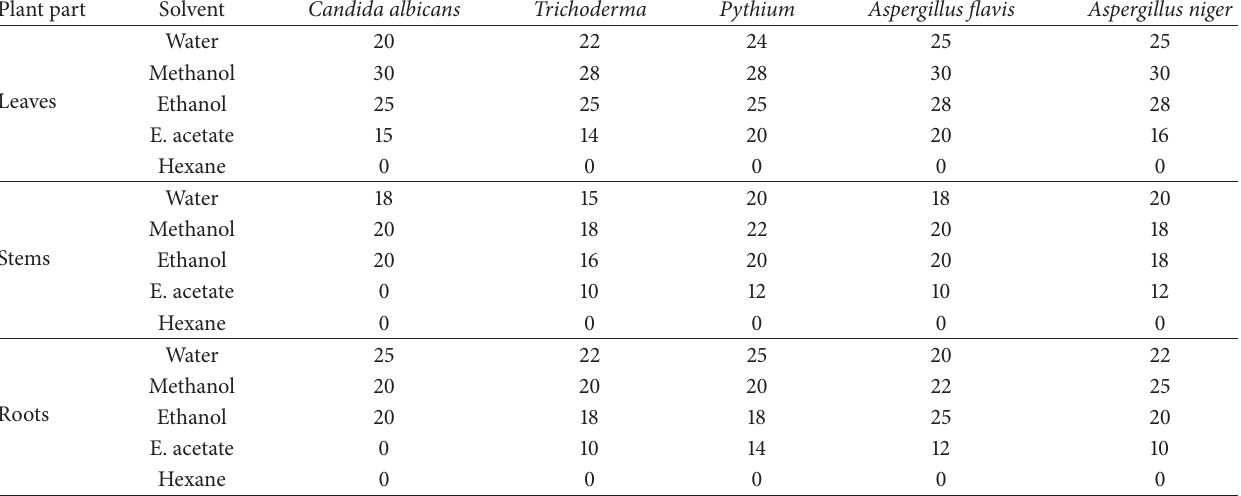
Extracts with zone of inhibition (ZI) representing sensitivity in millimeter (mm). Table 5: Antifungal activity of Adiantum capillus veneris extracts. Plant